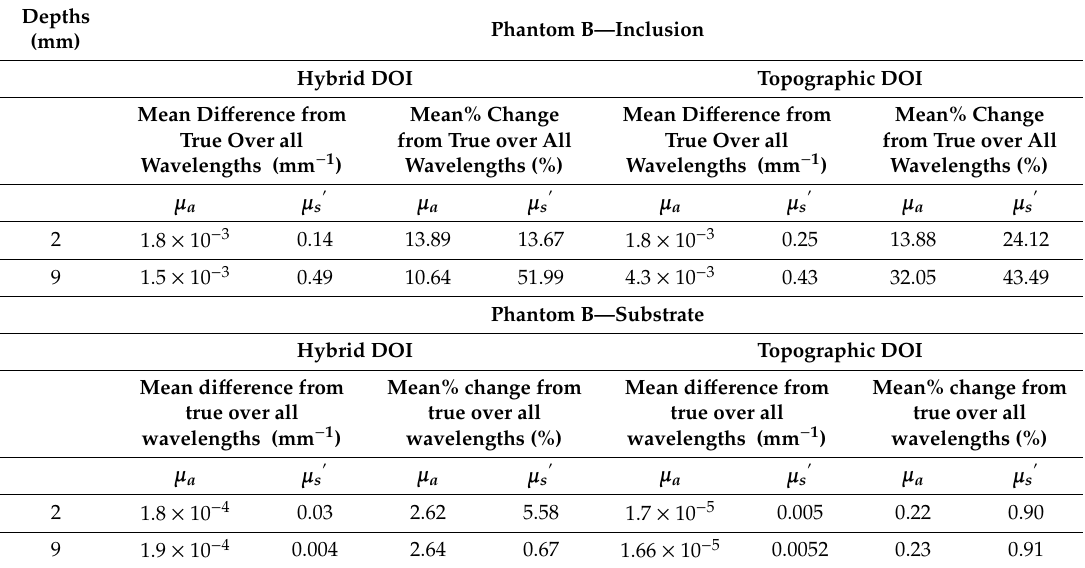
Table 5. Mean di ff erence and mean percentage change of recovered ( µ a , µ s (cid:48) ) from true ( µ a , µ s (cid:48) ) over all wavelengths for phantom